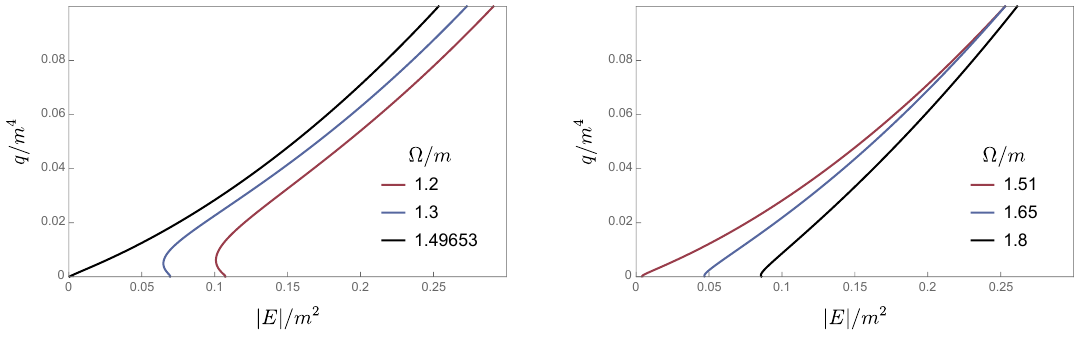
Figure 6 . The Joule heating q as a function of the electric (cid:12)eld E for black hole embeddings and several frequencies around the (cid:12)rst resonance. On the left (right) plots (cid:10) (cid:20) (cid:10) c ((cid:10) > (cid:10) c